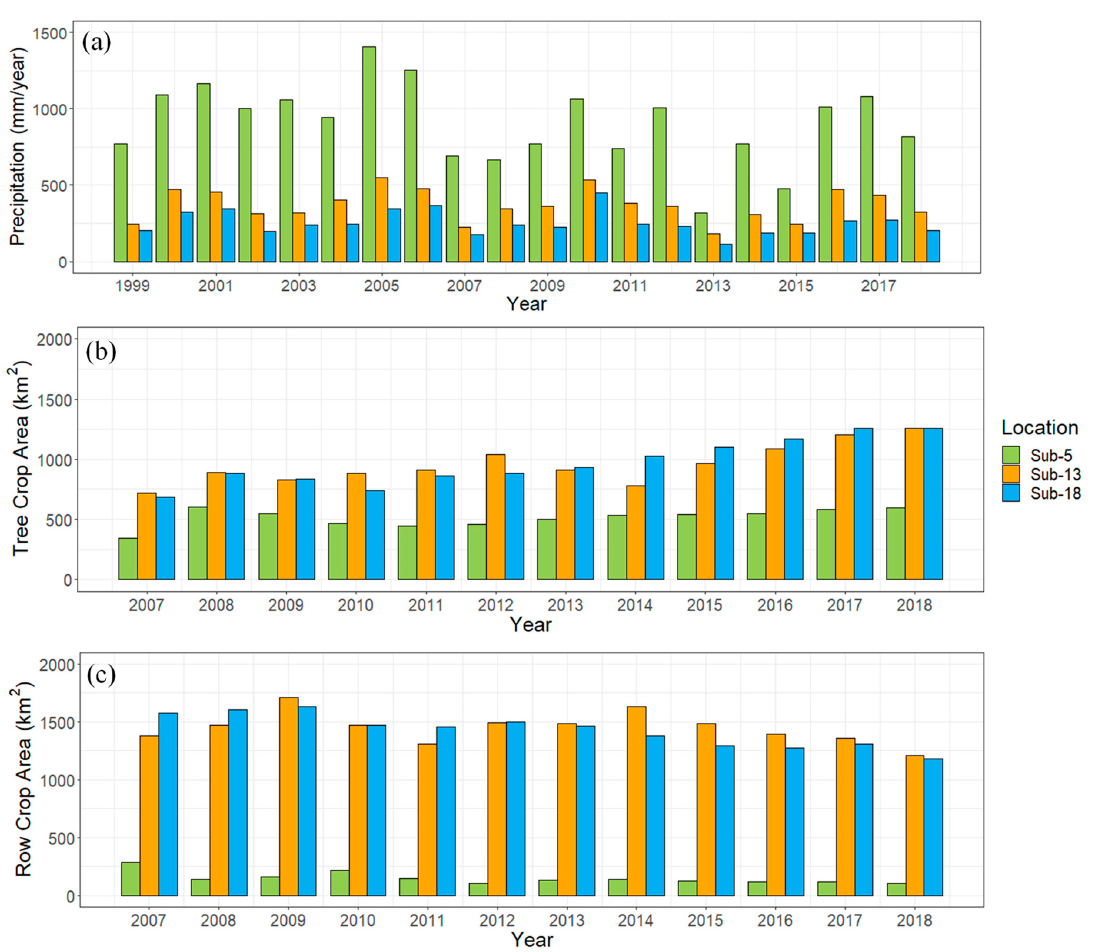
Figure 6. (a) Precipitation over selected subregions of Sacramento, San Joaquin and Tulare (the precipitation data is extracted from TRMM-3B43), (b) tree crop area in selected regions, and (c) row crop area in the selected regions